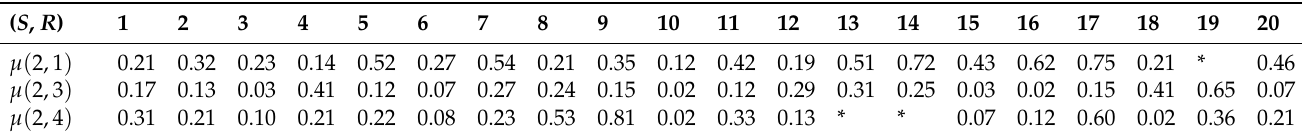
Table 3. µ ( i , j ) for twenty different chess positions ( S , R ) . The * in the table means blank, indicating that the opponent’s plane is in the staging area.